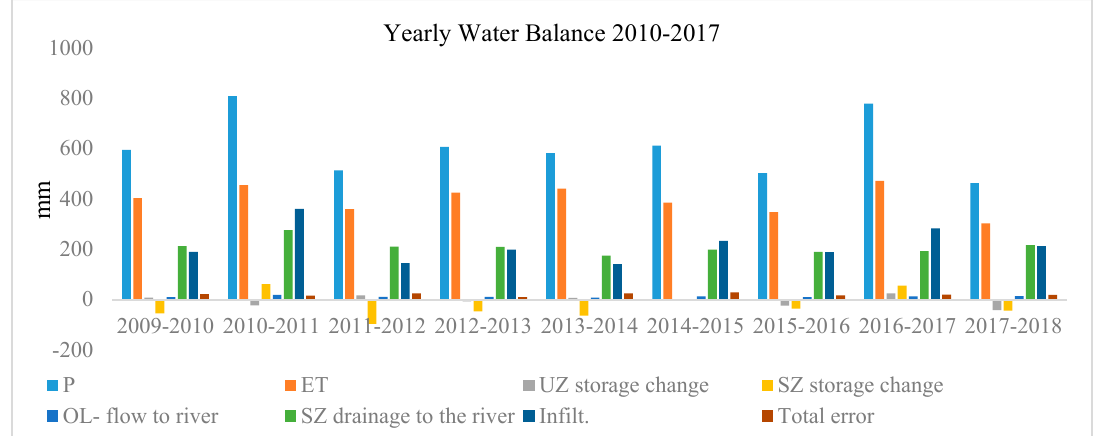
Figure 13. Water balance for the Tollense river catchment (400 km 2 ) for hydrological years 2010–2017. Negative values of water stored in SZ and UZ shows contribution to the surface water from SZ and UZ, respectively and vice versa.